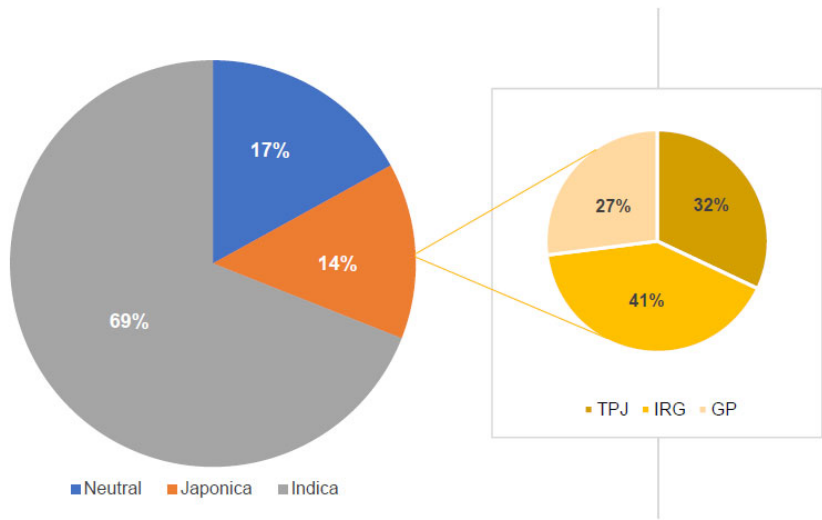
Figure 1. Frequency distribution of different alleles of S5 locus viz., S5-n , S5-i and S5-j in the set of 950 rice genotypes. TPJ, tropical japonica ; IRG, international rice germplasm; GP, local germplasm.